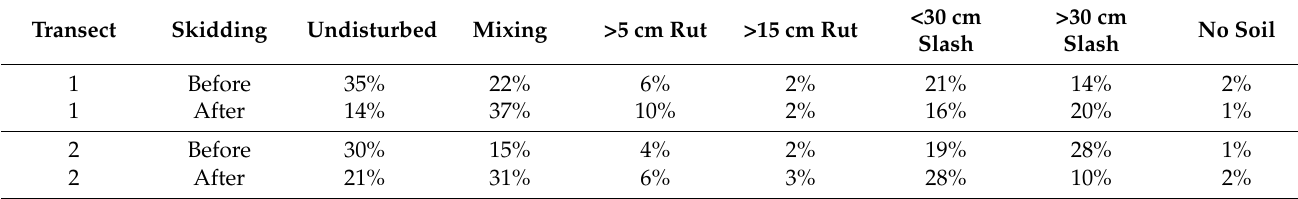
Table 7. Result of the soil survey conducted before and after skidding.